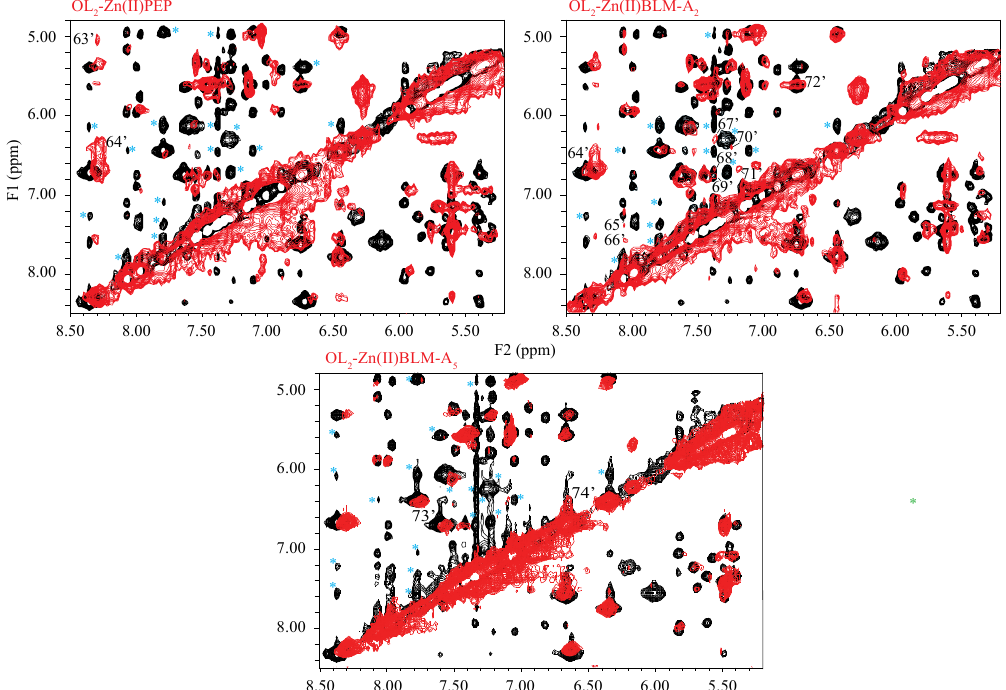
Figure 4. Overlays of the amino region of the NOESY spectra for samples in H 2 O acquired at 5 °C for free OL 2 (black) and OL 2 bound to each Zn(II)BLM (red). The missing NOE signals are indicated by astericks (*) and are identified in Table S1. New NOE signals are labeled with (’) and their corresponding assignments are listed in Table